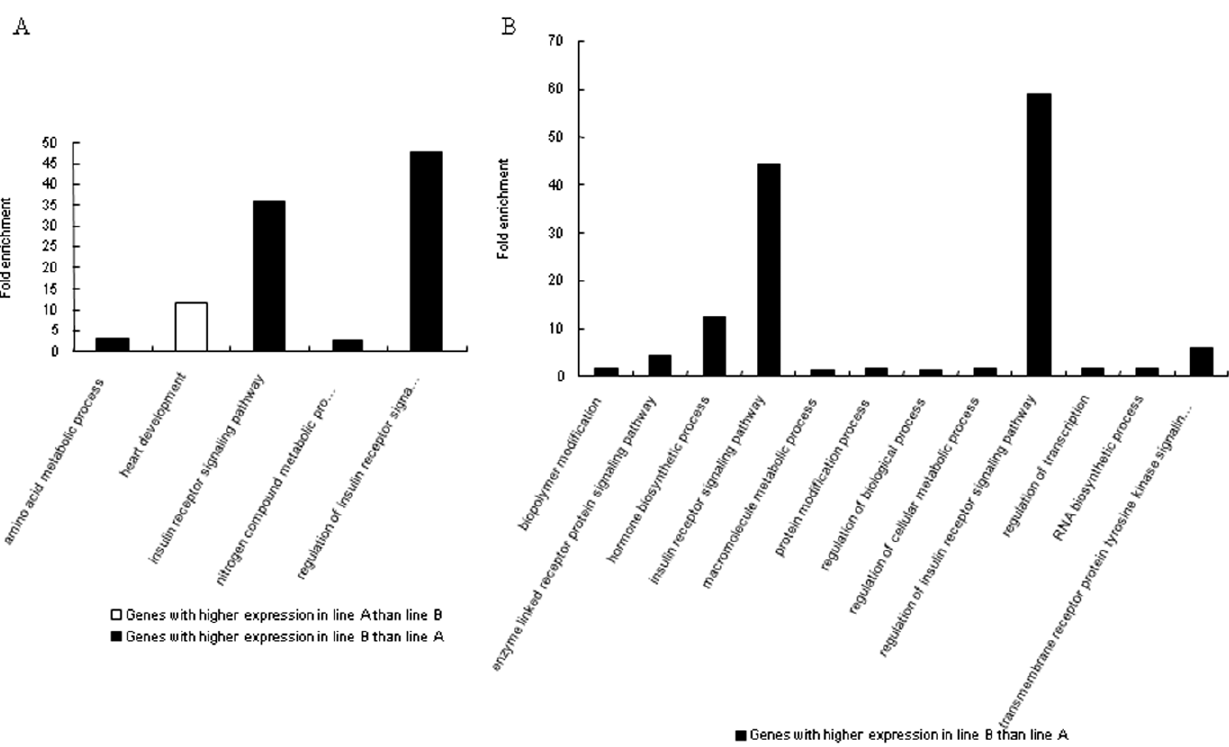
Figure 3. Enriched BP GO terms for significantly expressed genes between genetic lines. A: Enriched GO terms in the comparison of AN/ BN. Note: regulation of insulin receptor signal… represents regulation of insulin receptor signaling pathway. B: Enriched GO terms in the comparison of AI/BI. Note: transmembrane receptor protein tyrosine kinase signalin…represents transmembrane receptor protein tyrosine kinase signaling pathway.